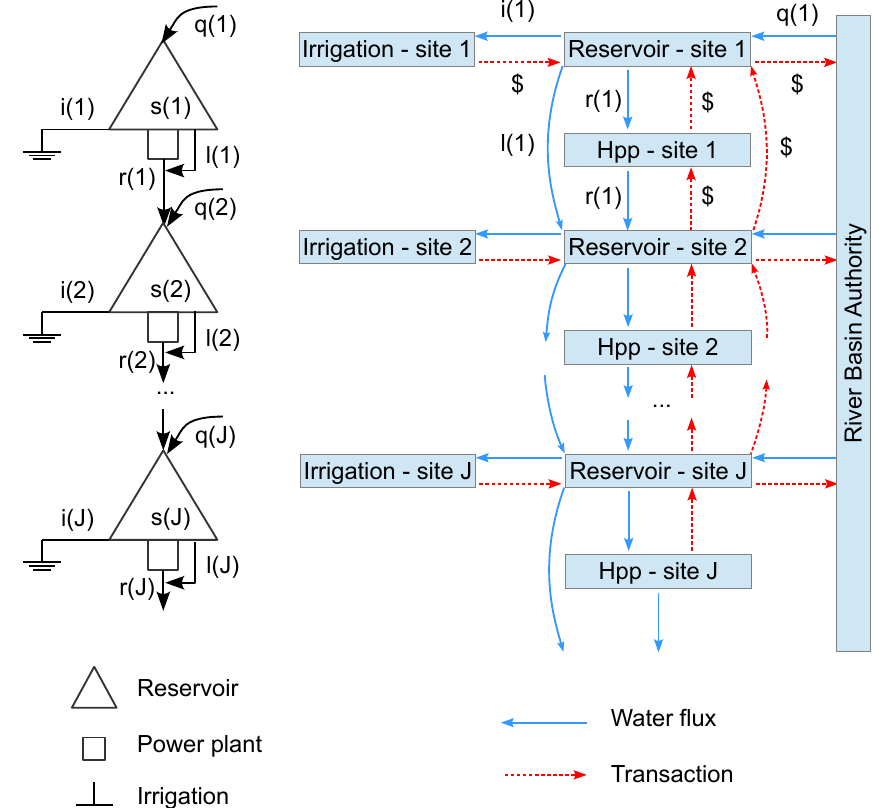
Figure 2. Cascade of J multireservoirs – water fluxes and financial